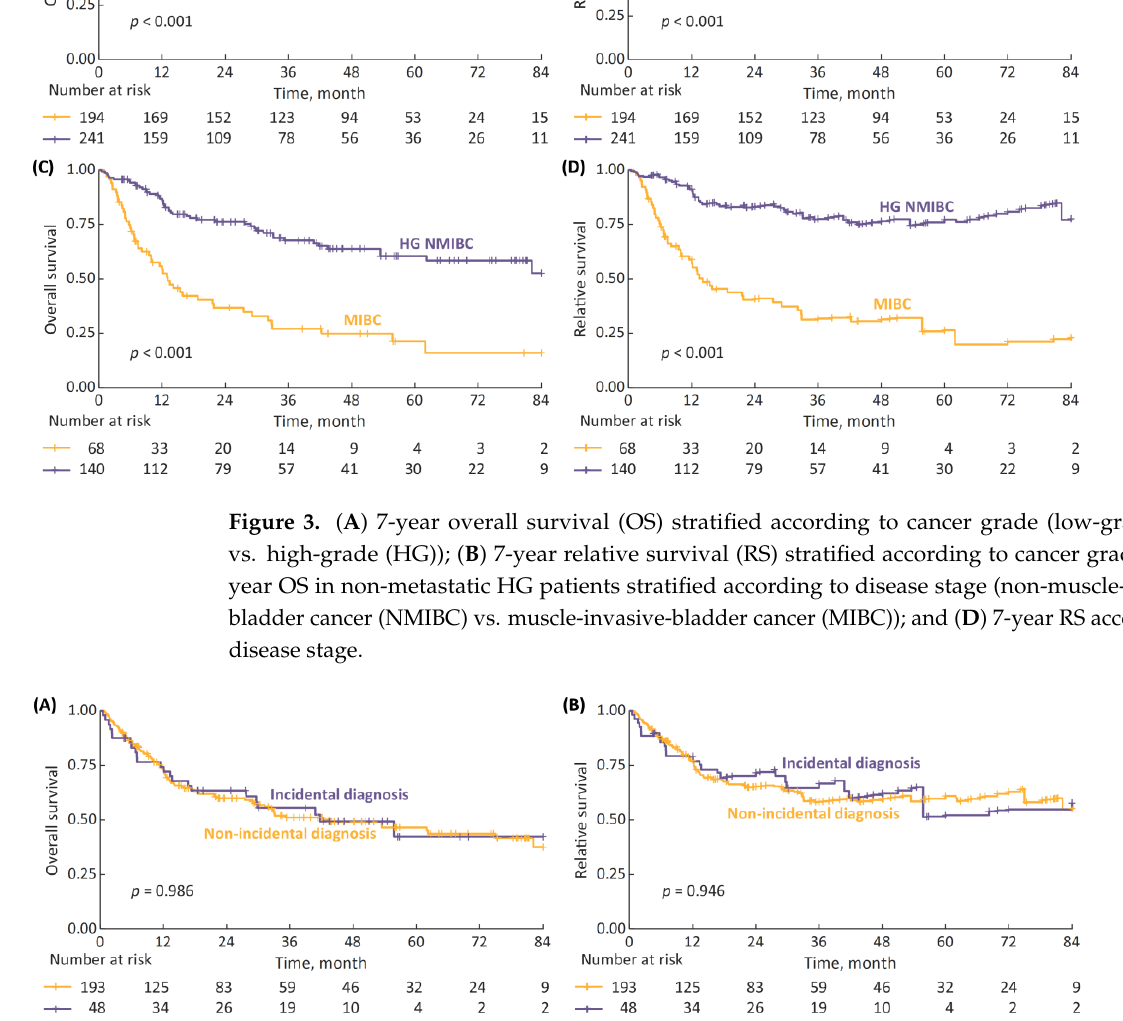
Figure 2. (A) 7-year overall survival (OS), stratified according to type of diagnosis: incidental diag- nosis performed with ultrasound vs. non-incidental diagnosis; and (B) 7-year relative survival (RS). The survival analyses stratified by disease characteristics demonstrated both the 7- year OS and RS to be significantly superior in patients with LG vs. HG cancer, as well as in cases of non-metastatic HG NMIBC vs. non-metastatic MIBC (Figure 3, p < 0.001 in all analyses).